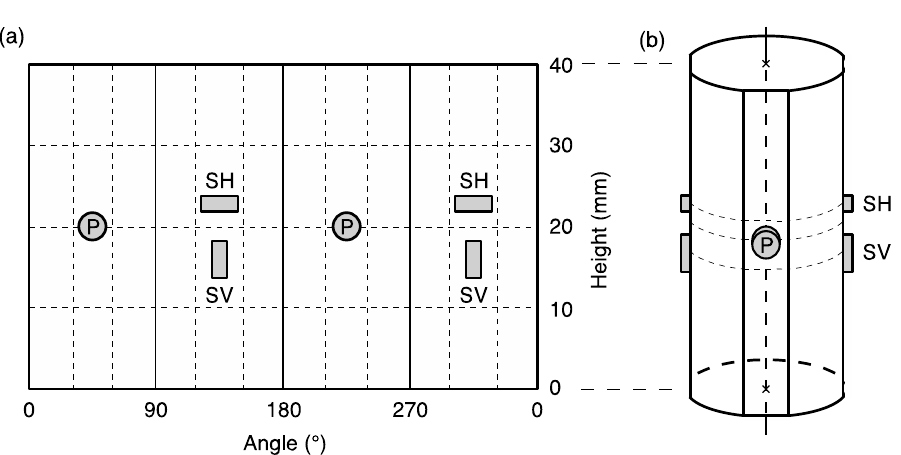
Figure 2. ( a ) Map of sensors around the sample. One P-wave and two S-waves along a direction perpendicular to the loading axis were generated by lead zirconate titanate piezoelectric transducers. S-waves were polarized in the planes horizontal (SH-wave) and perpendicular (SV-wave) to the axis. ( b ) Schematic view of a prepared sample.